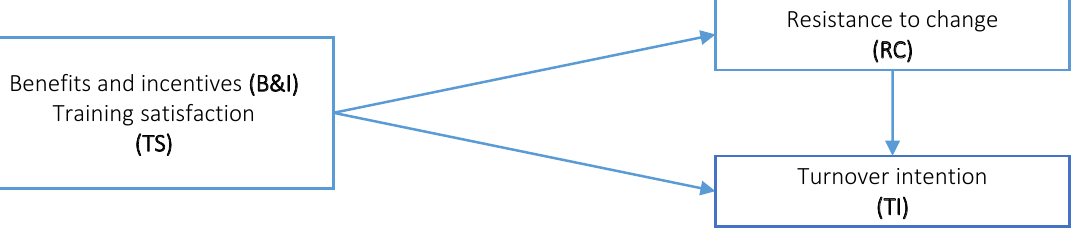
Figure 1. Conceptual